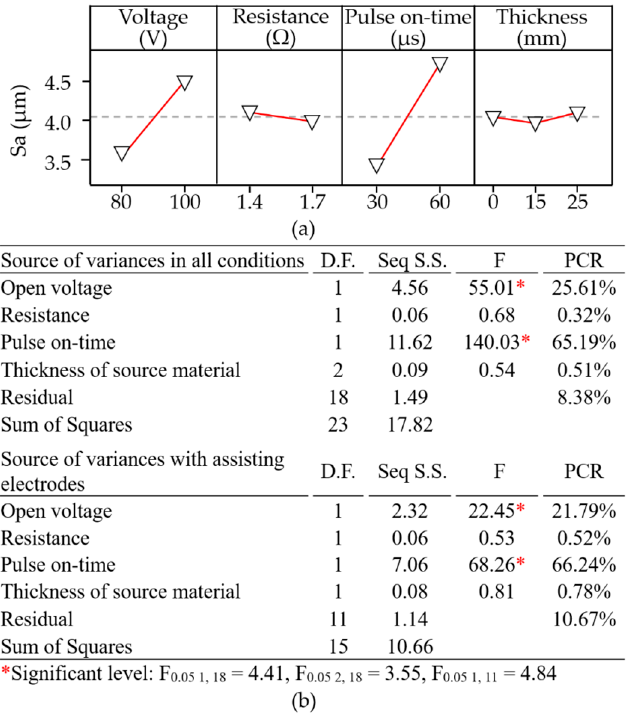
Figure 15. Statistical examination of: ( a ) main effect plots with operating parameter settings; ( b )ANOVA results for surface roughness (S a ).